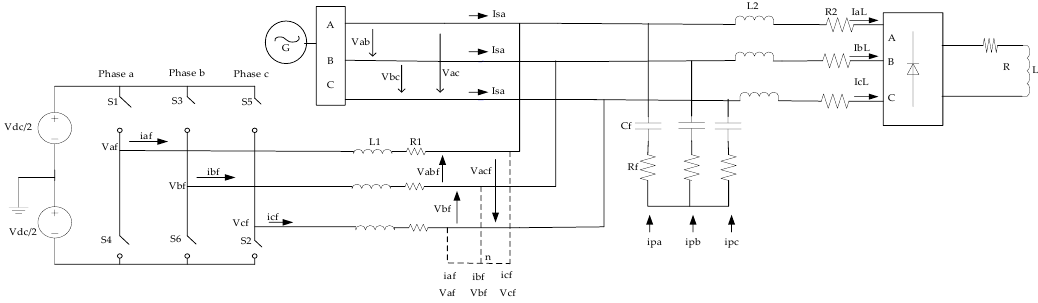
Figure 1. LCL-HPF system structure.